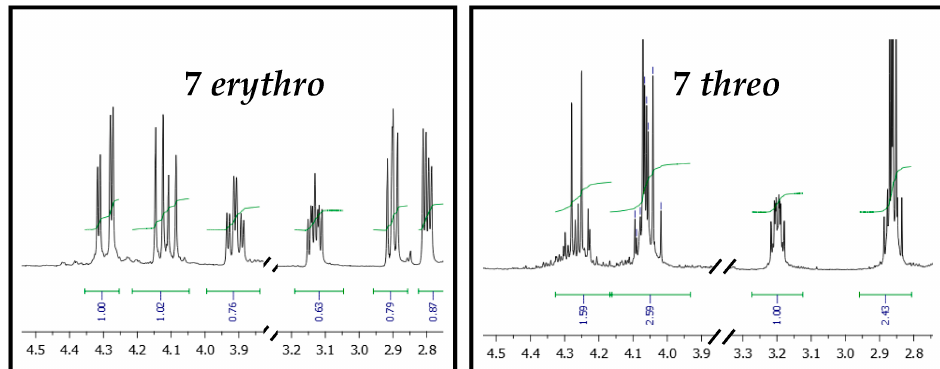
Figure 3. 1 H-NMR Spectra extracts of 7 erythro and 7 threo .